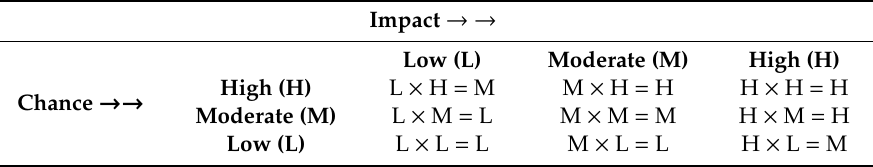
Table 4. Score rating (SR) = Impact rating × Chance rating.